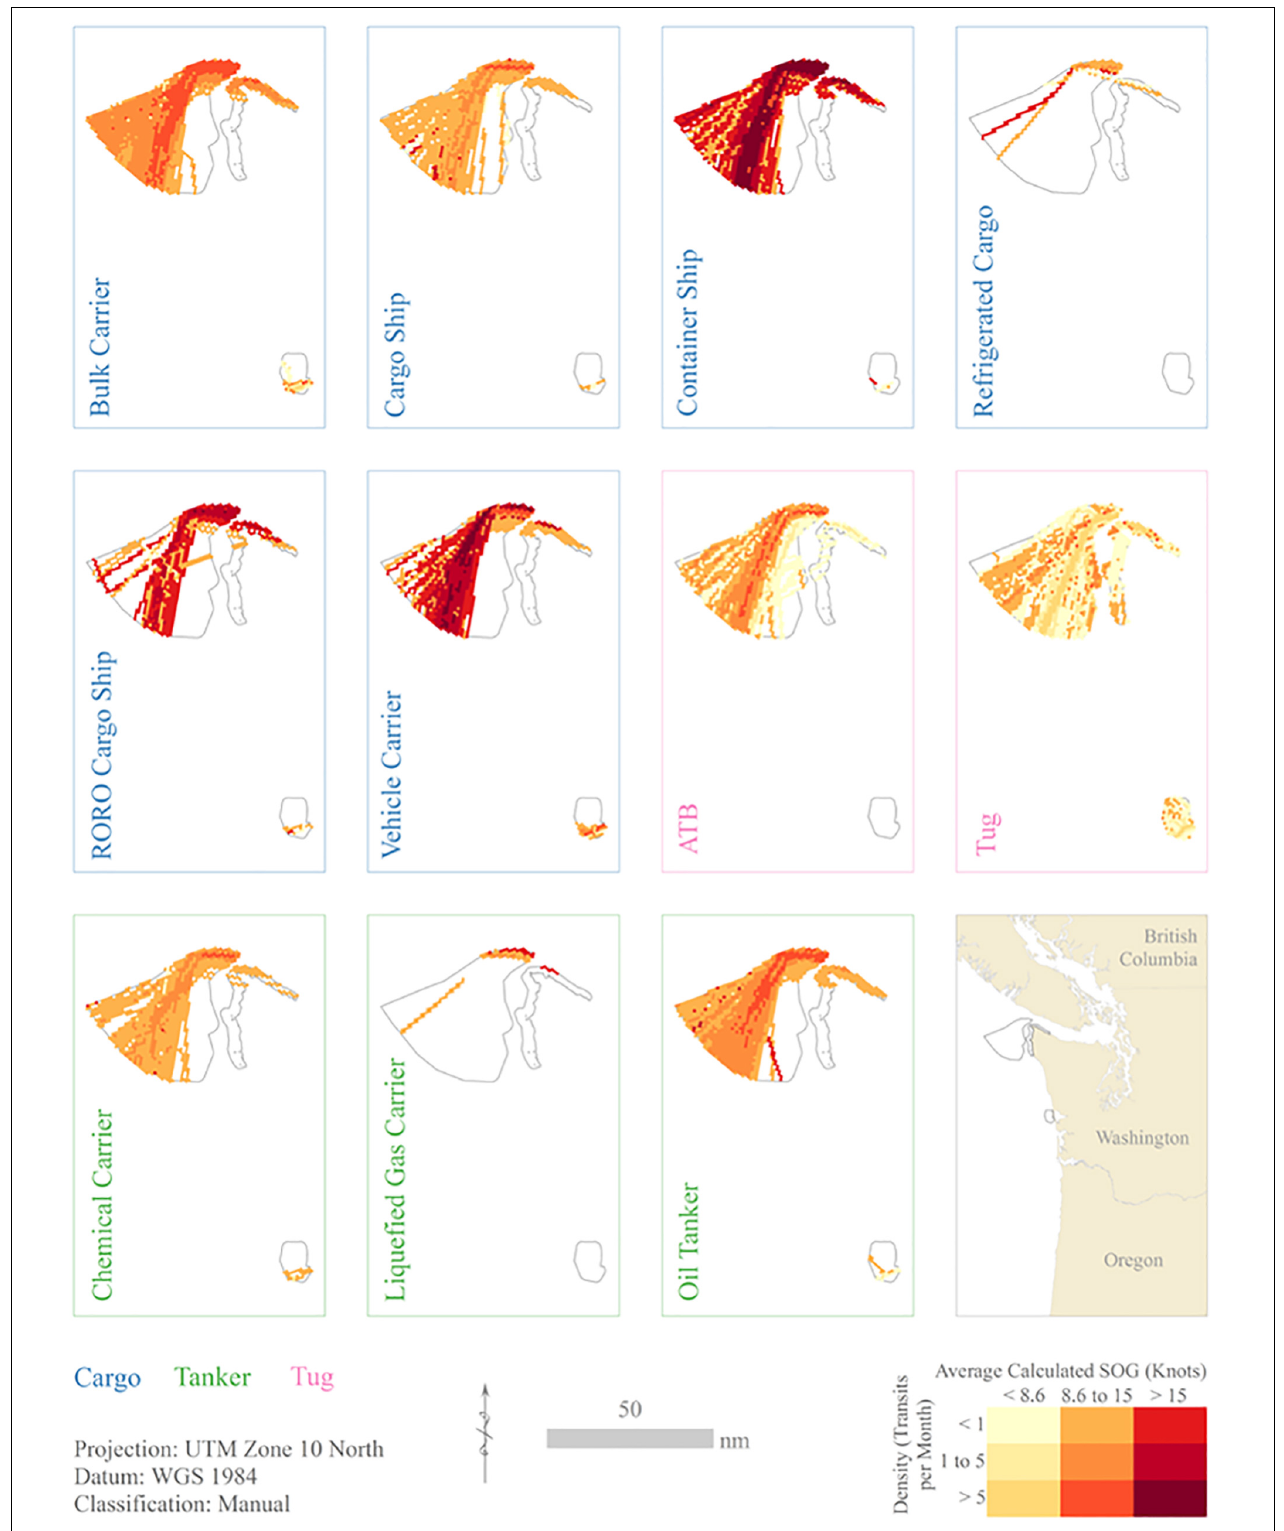
FIGURE 3 | Average calculated speed over ground (SOG) and vessel transits per month in the feeding Biologically Important Areas (BIA) for gray and humpback whales for 2013 and 2014. Darker colors represent faster average speeds and more transits per month for each vessel type. The unit of observation is the square statute mile